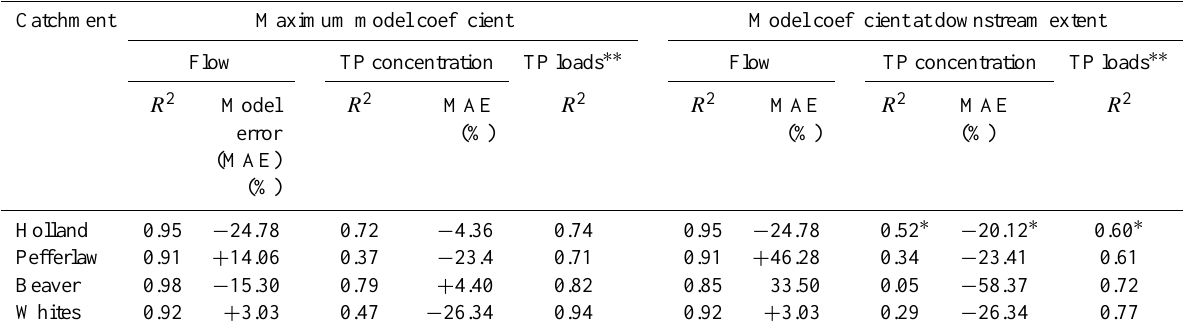
Table 4. Model performance statistics presented for locations of highest calibration accuracy and at downstream extent (for which cor- responding observed flow, TP and loads data were available). Results are reported to 2d.p. For individual performance statistics of each tributary, see Fig. 6.